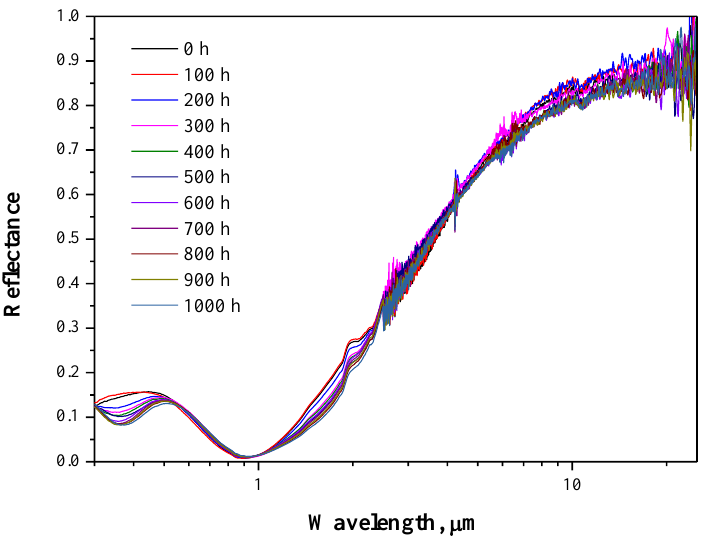
Figure 1. Reflectance spectra in the UV-visible-IR region of the multilayer coating before and after annealing for different times at 500 °C in ambient air. Table 1. The calculated absorptance and emittance of the as-deposited and annealed multilayer coatings.